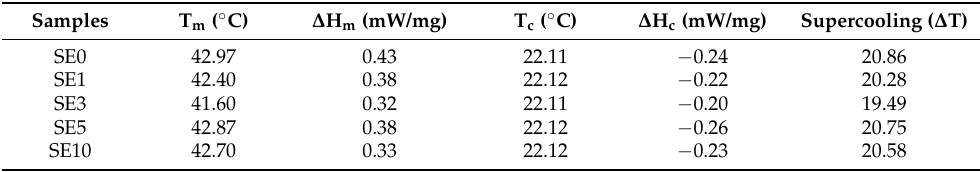
Table 2. Thermal parameters of the